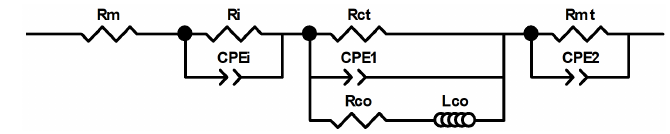
Figure 7. Equivalent circuit model of a µ